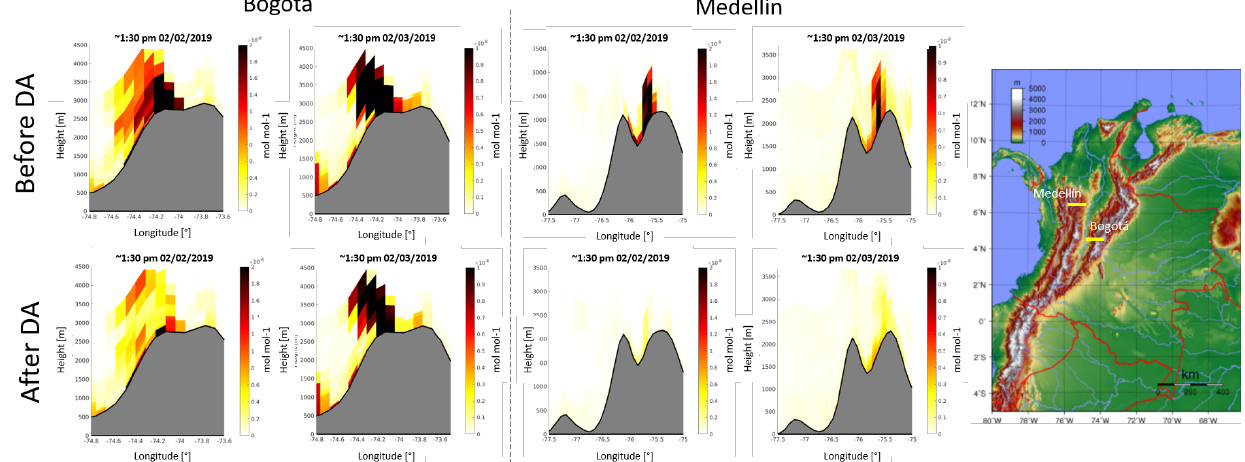
Figure 12. Transverse cut for NO 2 concentration over latitude = 6.2518° for Medellín and latitude = 4.609° for Bogotá. The emission parameter update has impact in the column of the model concentration output.